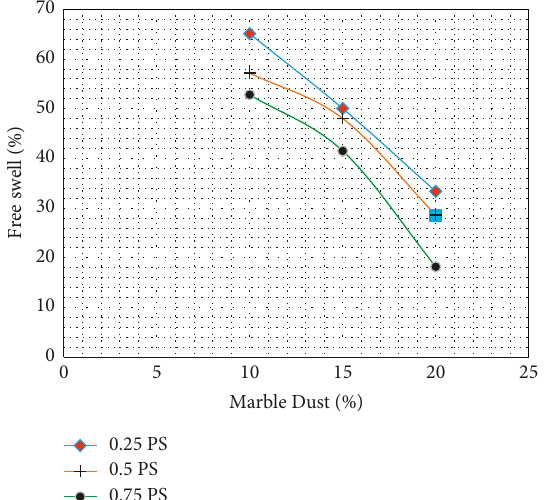
Figure 4: Variation of the free swell with marble dust and plastic